Question: What does this figure show? Answer in one sentence.
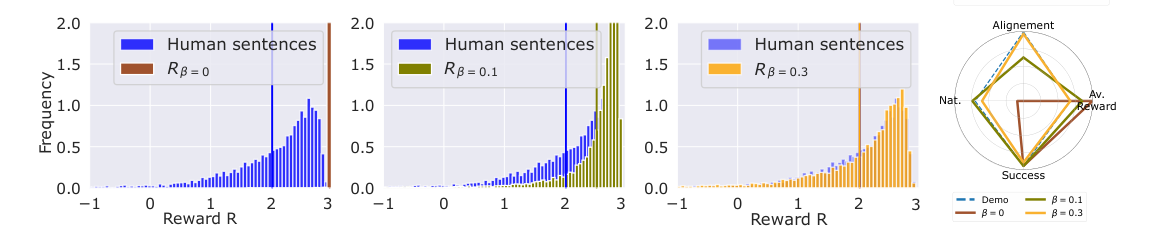
Answer: Results of the Movie review task (left) Comparison between the reward distribution of human demon- strations and LLM generations for the different methods. Vertical lines mark the mean of the distribution. (right) Normalized evaluation score of each LLM. RCfD outperforms the base model and SFT by matching the reward demonstration distribution. Absolute scores are provided in Appendix D. If carefully tuned, optimizing Rβ can match the reward distribution, but subtle changes in β also induce drastic behavior changes. When β = 0, the LM achieves near-optimal rewards, yet the policy is degraded (naturalness close to 0), illustrating an instance of ROO.